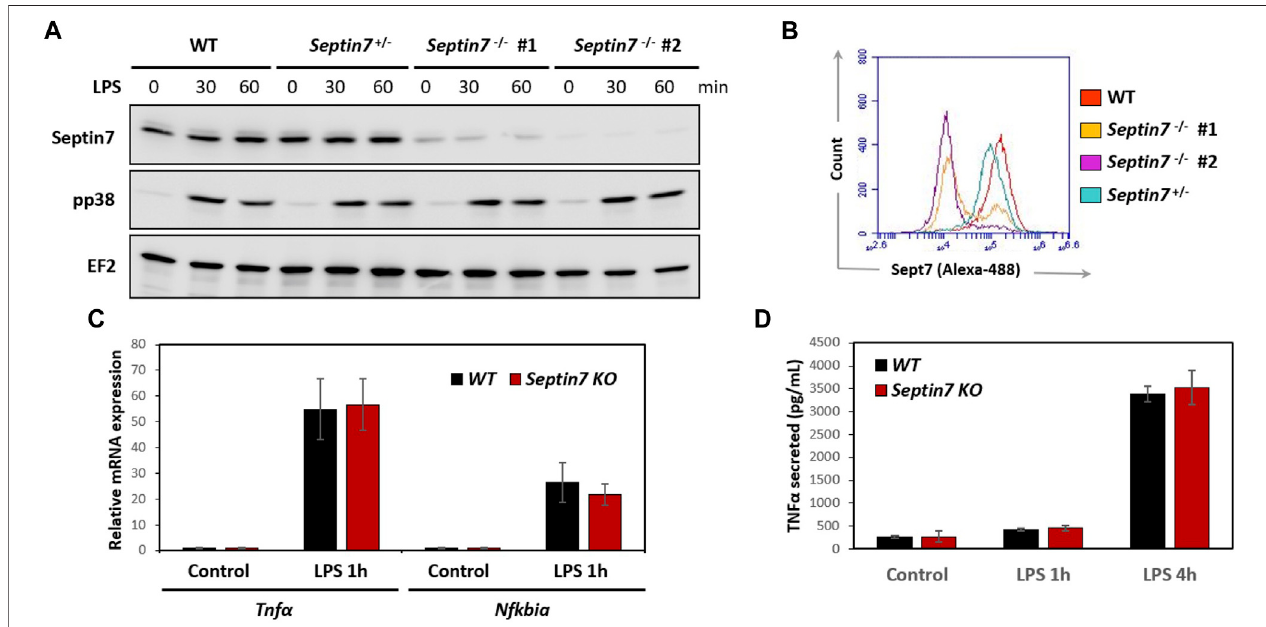
FIGURE 2 | Septin7 KO BMDMs respond normally to LPS stimulation. (A,B) Immunoblot analyses of LPS-stimulated BMDM lysates (A) and Flow-cytometry (B) showef fi cientdepletionofSeptin7intwohomozygous Septin7 -KOcells.However,p38activationisindistinguishablebetweentheKOandcontrolcells (A) .EF2isshown as loading control. (C) LPS-induced expression of Tnf α and Nfkbi α are not signi fi cantly affected upon Septin7 -deletion in BMDMs ( n (cid:1) 4 independent treated culture wells, p -values > 0.3 for 1 h LPS-stimulated samples). (D) LPS-induced secretion of Tnf α quanti fi ed by ELISA reveal no signi fi cant difference between Septin7 -KO and Septin7 -Wt (WT) BMDMs ( n (cid:1) 4 independent treated culture wells, p -values > 0.3 for 1 and 4 h LPS-treated).